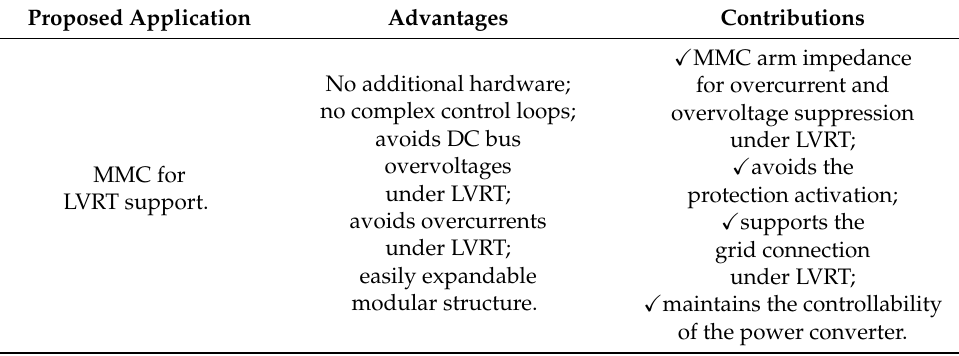
Table 2. Summary of the proposed application for LVRT